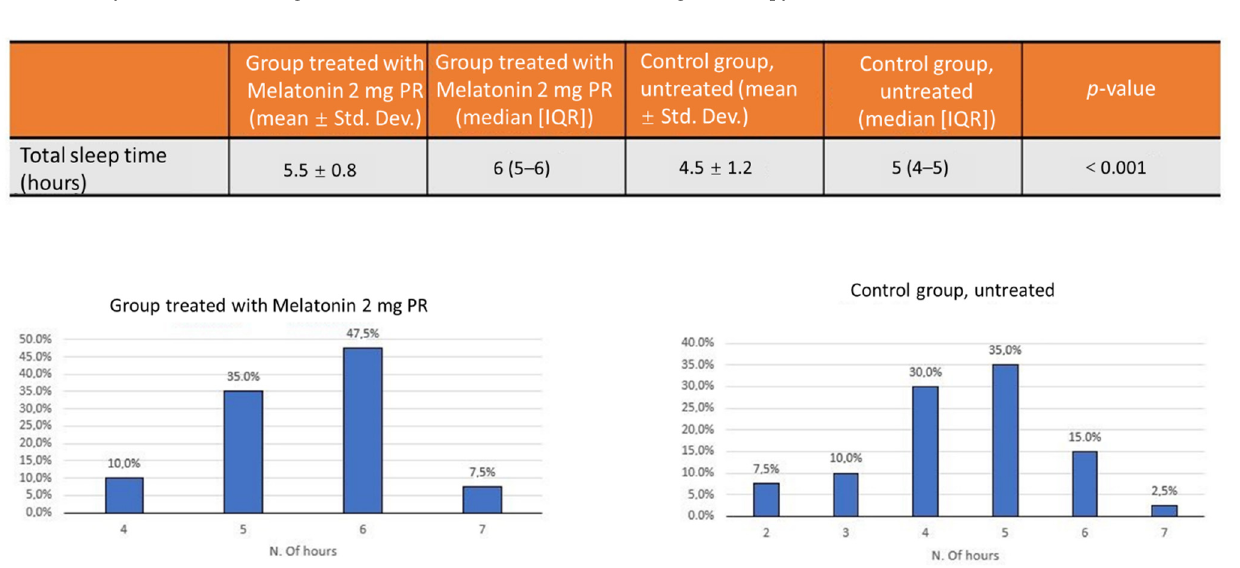
Figure 2. The group of patients treated with PRM 2 mg had a median of 6 h of sleep (47.5%), compared with a median of 5 h (35%) in the untreated group.